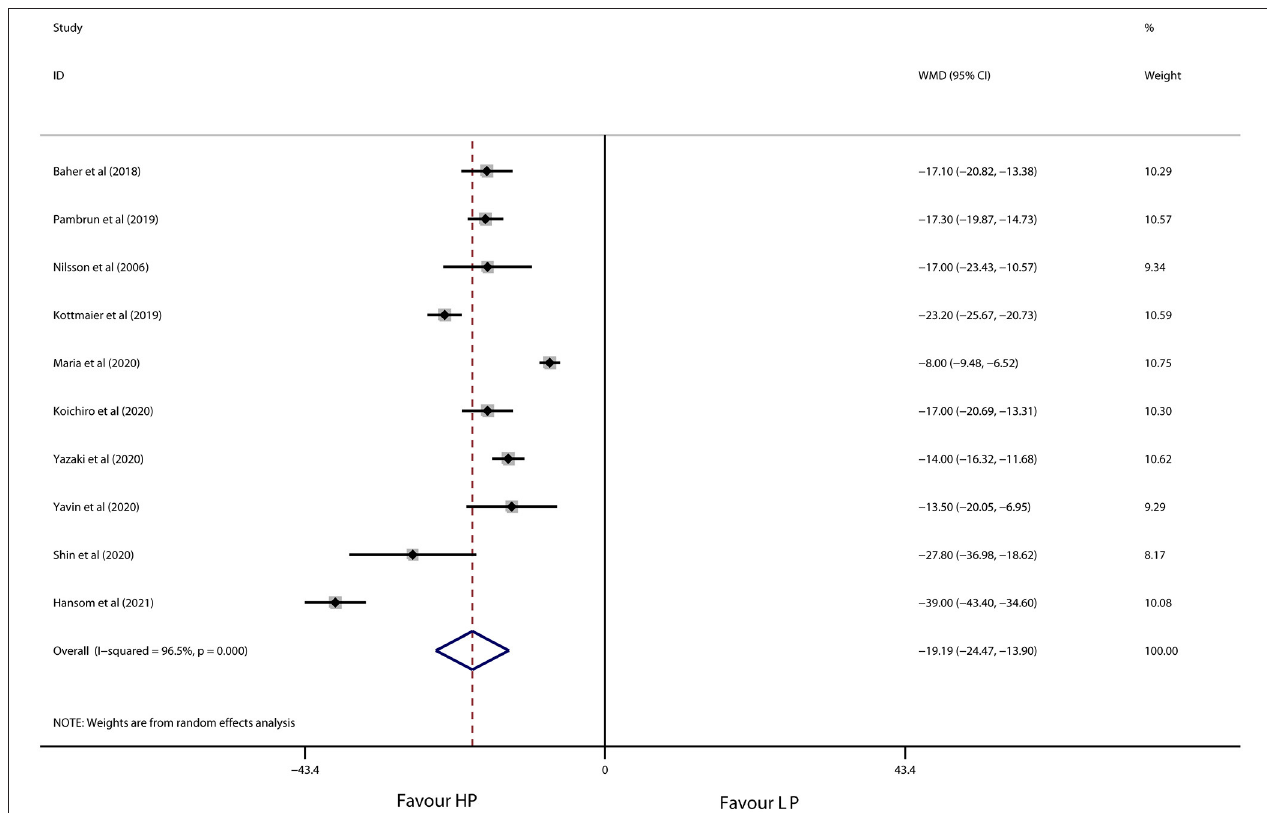
FIGURE 4 | Forest plot of RF ablation time for high-power ablation vs. conventional-power